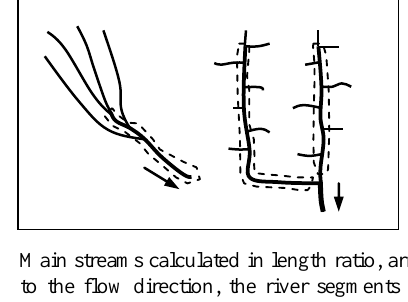
Main streams calculated in length ratio, arrow refers to the flow direction, the river segments in